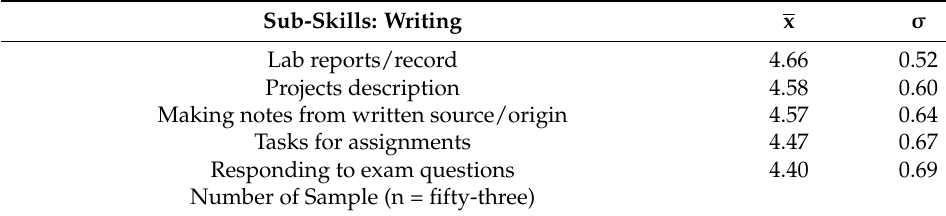
Table 5. The Significance in the Enhancement of Writing Skills.